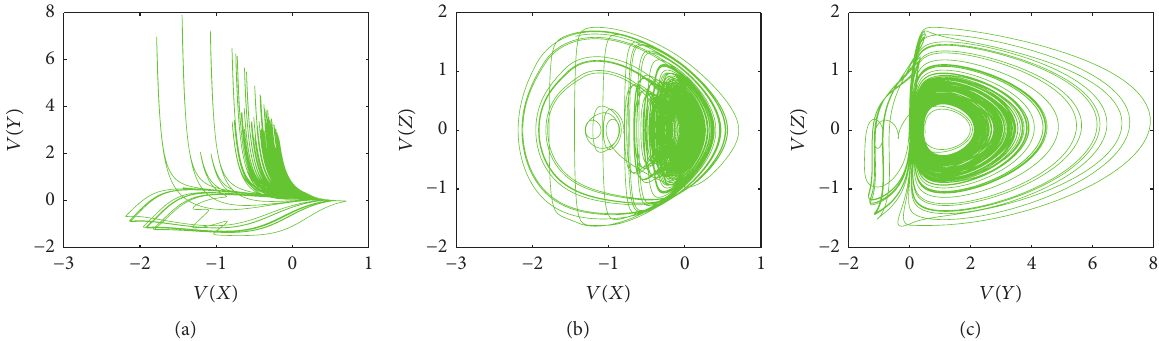
Figure 8: PSpice chaotic attractors of the circuit with cloud-shaped equilibrium in (a) 𝑋 - 𝑌 plane, (b) 𝑋 - 𝑍 plane, and (c) 𝑌 - 𝑍 plane.